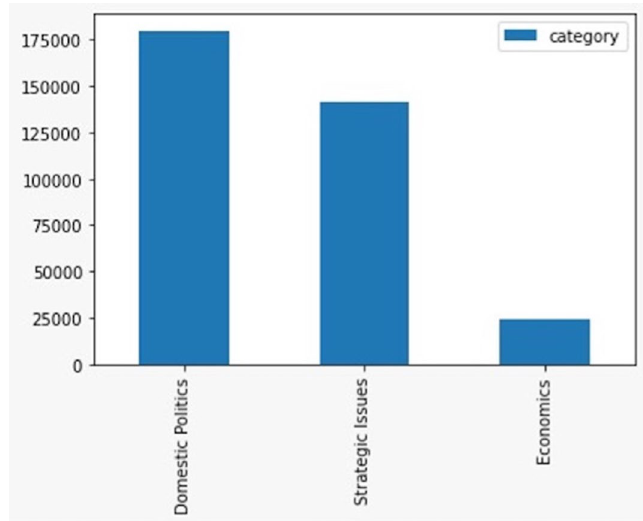
Fig. 5 Topic classification of RCEP discussions